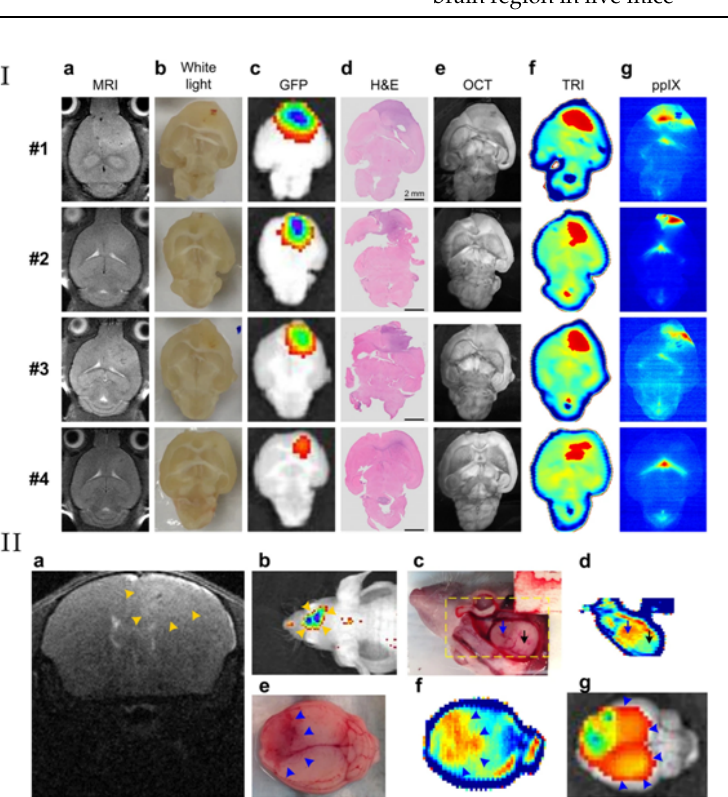
Figure 10. I : Mice tumor ex-vivo discrimination with ( f ) TPI and other imaging. II : ( a ) T2-weighted coronal MRI image. ( b ) In vivo GFP fluorescence image. ( c ) White light image of exposed brain tumor that was in contact with the quartz window. Yellow dashed box indicates region of measured TRI image. ( d ) In vivo peak-to-peak TRI image. ( e – g ) White light, TRI, and GFP fluorescence images of extracted whole brain, respectively. ( f ) In-vivo tumor detection in a mouse via TPI. Yellow-orange arrowheads indicate the assumed tumor region. Tumor regions (blue arrow) were well-discriminated from normal brain regions (black arrow) in the live animal. The gross tumor regions, determined by each image (blue arrowheads), were well-discriminated in the TPI image and even in the white light image (violet arrow). Adapted from